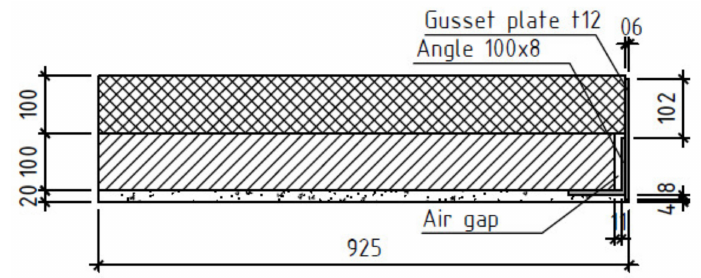
Figure 20. Calculation scheme with a gusset plate (units: mm). Thermal insulation—mineral wool with a density of 200 kg/m 3 and a thickness of 100 mm.